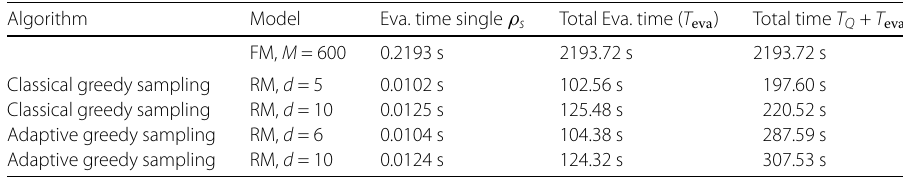
Table 5 Evaluation